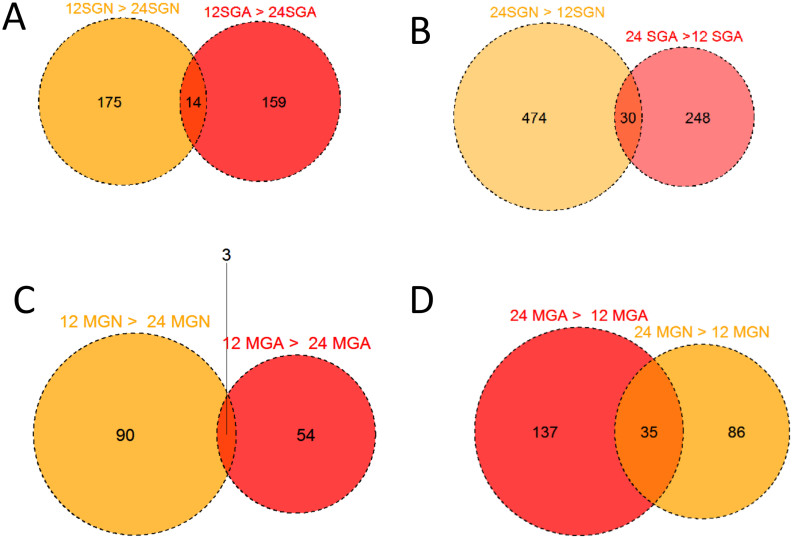
Venn diagrams representing pairwise comparisons of transcripts at least ten-times (10×) overexpressed in the salivary glands (SG) or midguts (MG) of nymphal (N) or adult (A) Ixodes ricinus ticks fed for up to 12, or from 12 to 24 hours, on a host.(A) Comparison of transcripts 10× overexpressed at 12 h vs. 24 h of feeding in nymphs and adults. (B) Same as A, but transcripts overexpressed at 24 h vs. 12 h. (C) Same as A, but using MG instead of SG. (D) Same as B, but using MG instead of SG.